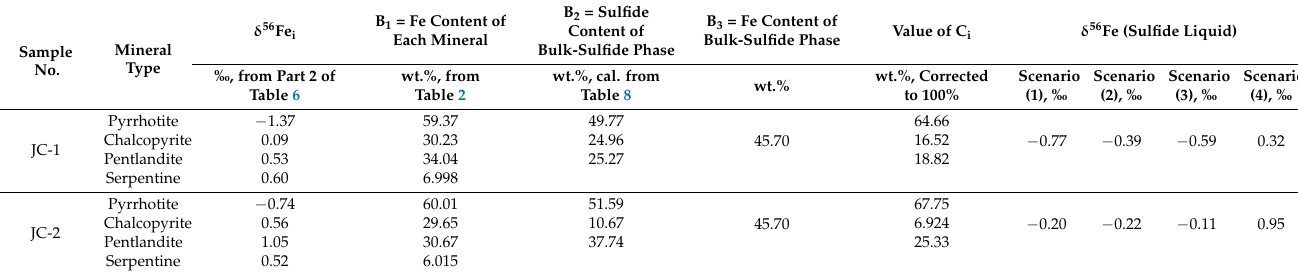
Table 9. Calculated iron isotope composition of bulk-sulfide phase in net-textured ore samples.